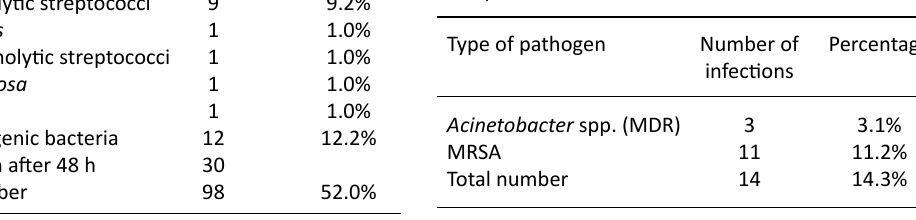
Table 4-c.3. Multidrug-resistant isolates of the pus samples